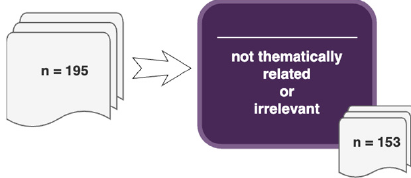
Figure 3. Eligibility stage.